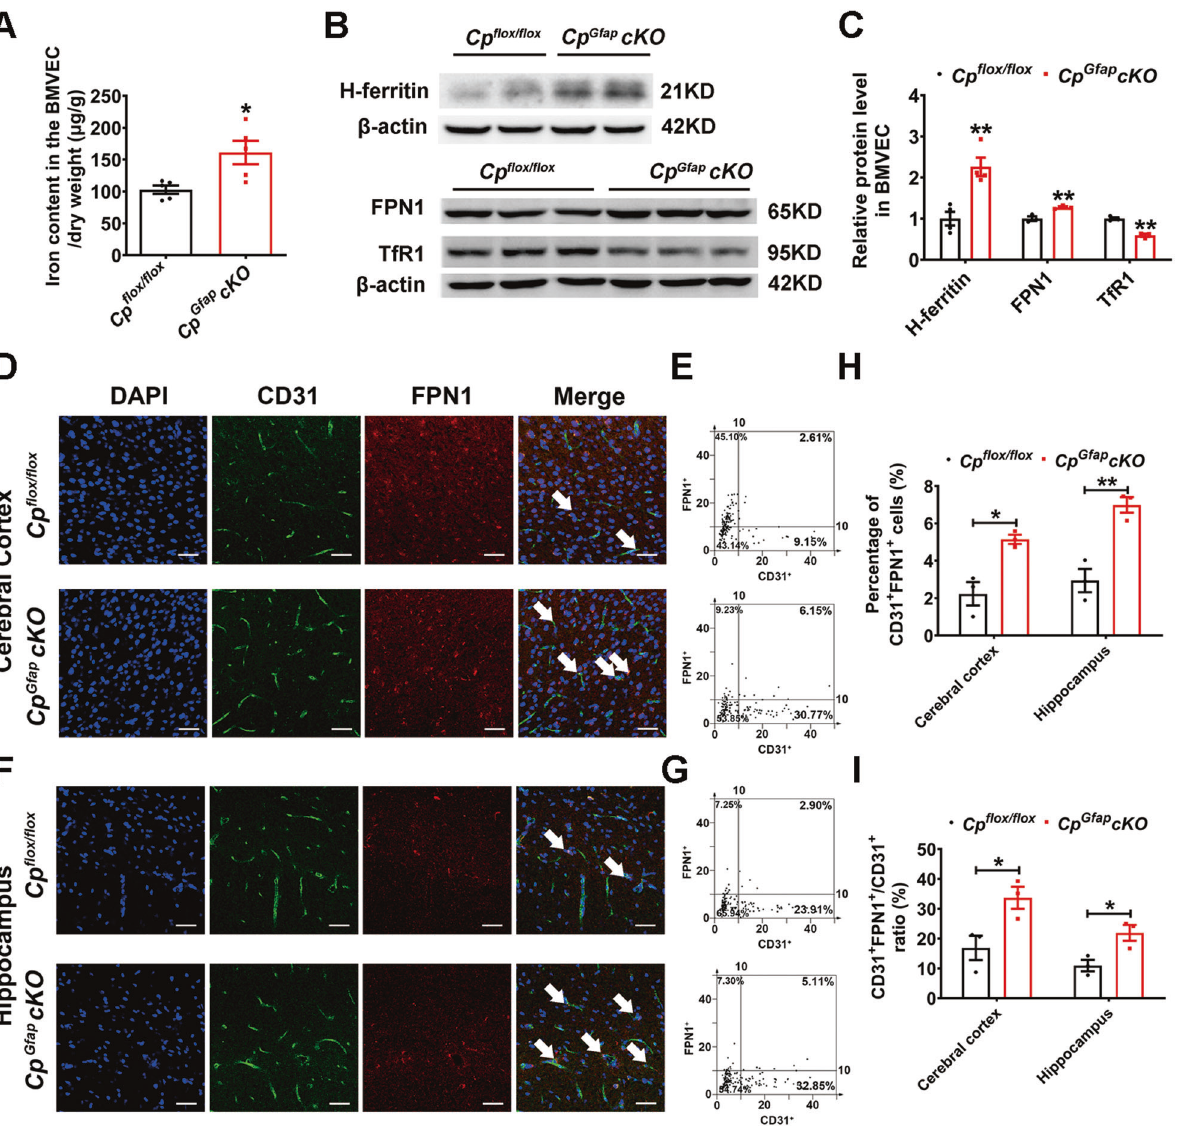
H-ferritin, FPN1 and TfR1 protein levels in BMVECs was normalized to β -actin, which was relative to that of Cp fl ox/ fl ox mice. ( n = 4 for H-ferritin; n = 3 for FPN1 and TfR1). D-I: Double immuno fl uorescence labeling of FPN1 and CD31 in the cerebral cortex ( D ) and hippocampus ( F ) in Cp fl ox/ fl ox and Cp Gfap cKO mice. The intensity of CD31 + and FPN1 + cells in the cerebral cortex ( E ) and hippocampus ( G ) is shown in scatter diagrams. Quanti fi cation of the percentage of the CD31 + FPN1 + cells ( H ) and the ratio of CD31 + FPN1 + / CD31 + ( I ) are shown. ( n = 3). DAPI was used